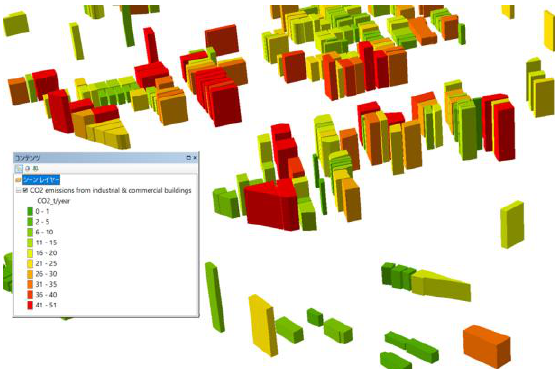
Figure 6. extraction of the industrial &commercial emissions by building level shown by 3